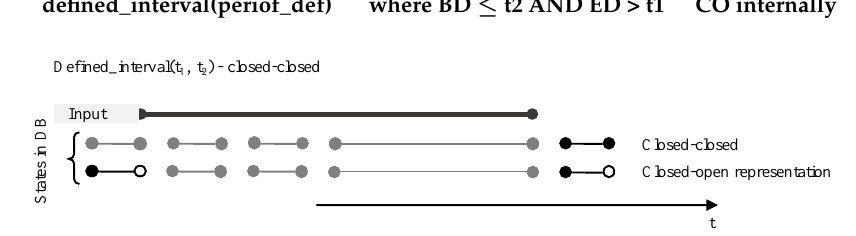
Figure 13. Event definition—Closed-Closed model.